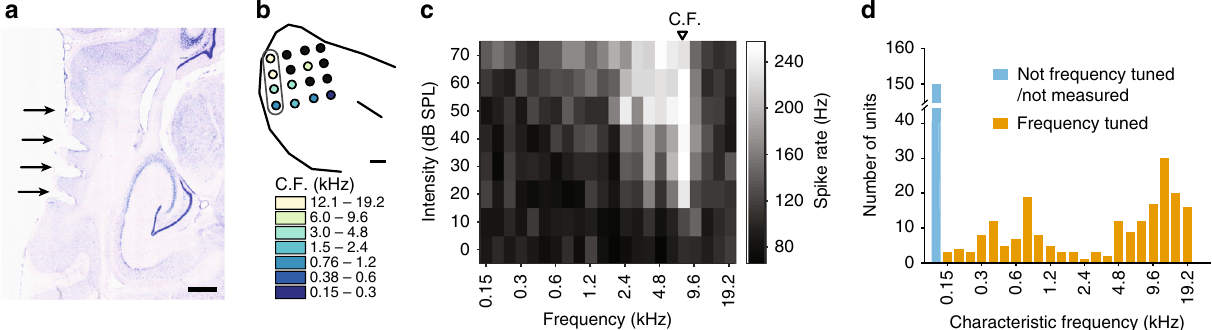
Fig. 2 Experimental procedures. a Nissl-stained brain section of F1310 showing electrode tracks in A1 marked with electrolytic lesions (black arrows) of one column of the 4 × 4 electrode array. The locations of the electrode penetrations were clearly visible on the surface of the brain post-mortem, indicated in ( b ) with each circle representing the electrode sites. The circles are coloured according to the characteristic frequency (C.F., kHz) tuning of the units recorded from that electrode, assessed from frequency response areas ( c ) measured in response to pure tones. Black- fi lled circles indicates that no C.F. could be estimated for that electrode. The grey outline indicates the electrode tracks shown in ( a ). c Example, frequency response area showing a unit with C.F. of 7.6 kHz. d Distribution of characteristic frequencies for all recorded units. Scale bar in ( a ) and ( b ) indicates 900 µ To assess changes in spatial tuning properties of neurons with differing spatial cue availability, we recorded the activity of 398 sound-responsive units from the left and right A1 while ferrets performed the task (total across all stimuli, ferrets, electrodes and recording depths, recording location con fi rmed with frequency tuning and post-mortem histology, Fig. 2). Spatial tuning was calculated during task performance by considering the neural response to the reference sounds only (Fig. 3).